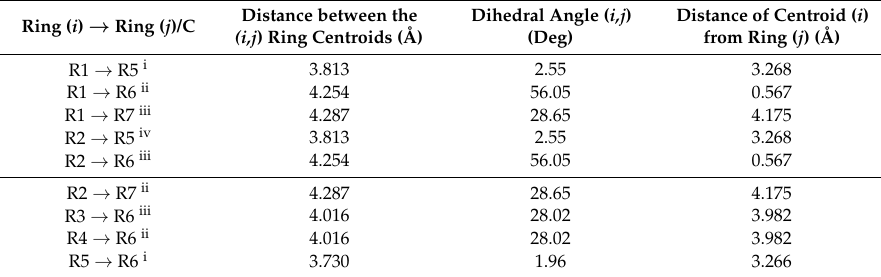
Table 2. π - π Interactions (Face-to-Face) and C- π Interactions in compound ( 1 ) a .